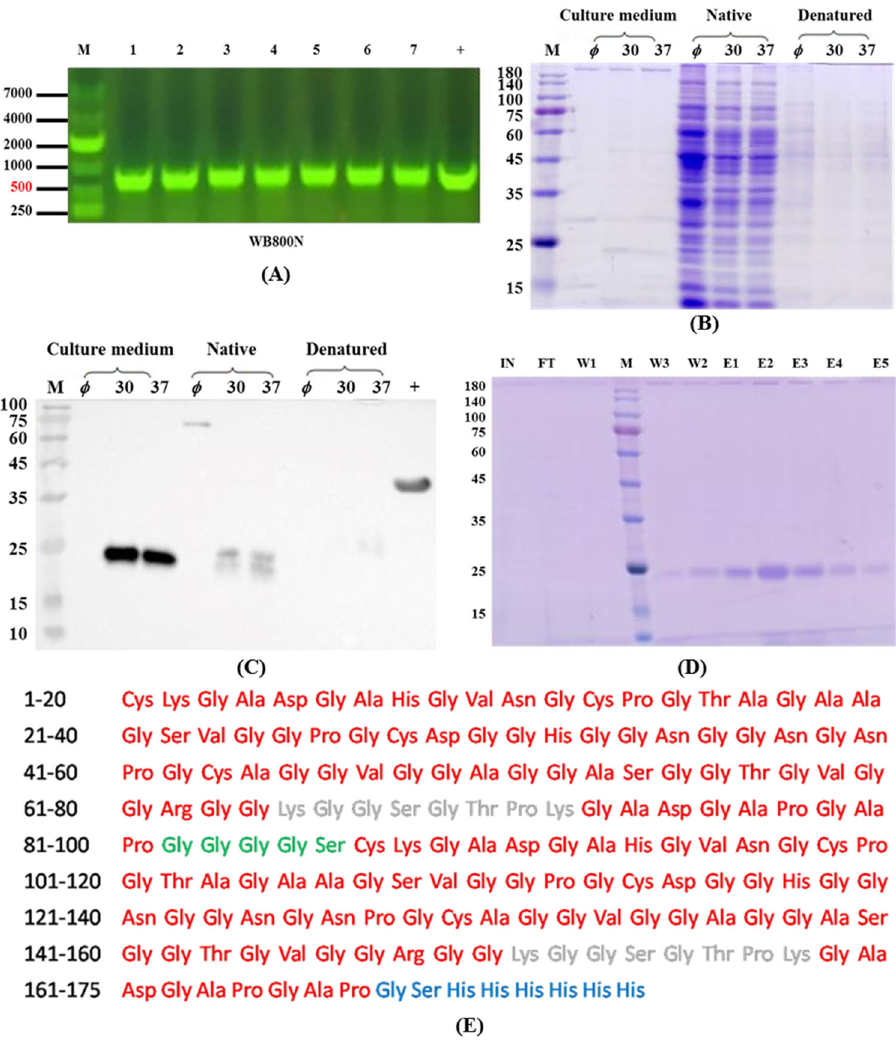
Fig. 1 Expression and identi fi cation of rsfAFP in B. subtilis WB800N. A PCR detects positive clones. M: DNA marker DL10000; lanes 1 – 7: recombinant plasmid; + : positive control. B Expression result. Coomassie blue staining. MW: molecular weight marker. ϕ : Transformed cells not induced. C Western blot detects expression results. MW: molecular weight marker. ϕ : transformed cells not induced. + : positive control. D Target protein puri fi cation pro fi le. IN: input; FT: fl ow through; MW: molecular weight marker; W1 – W3: wash with TBS buffer with 0, 30, and 50 mM imidazole, respectively; E1 – E5: eluted with TBS buffer with 100, 150, 200, 250, and 400 mM imidazole, respectively. E Sequence cover situation of rsfAFP by Nano LC-MS/MS spectrometry. The red section indicates the peptides matching the peptides of the snow fl ea antifreeze protein. The gray section indicates the missing fragments in the Nano LC-MS/MS test. The green section of peptide is GS linker. The blue section of peptide is